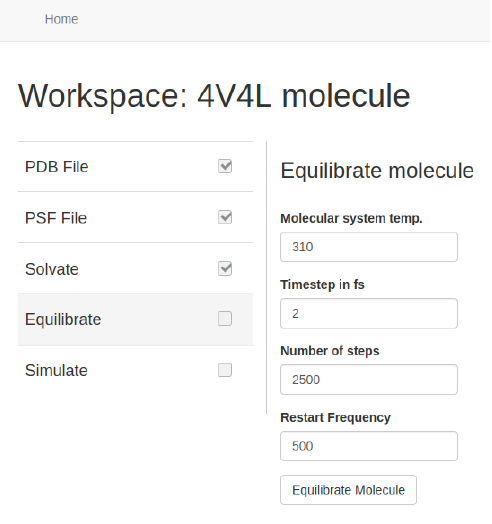
Figure 11. Stage of equilibration of the molecular system. Users can set the relevant parameters in the balancing process.